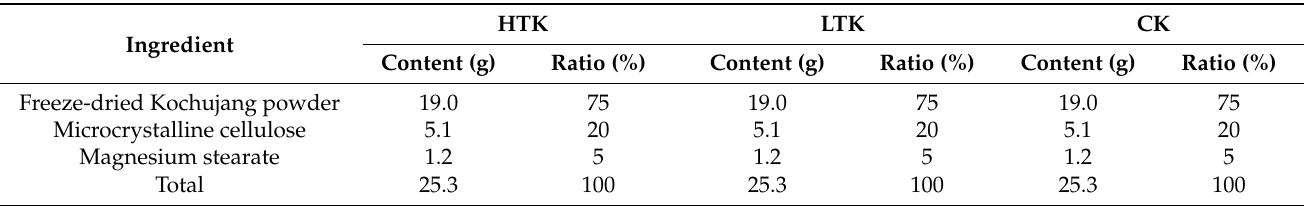
Table 1. Composition of Kochujang